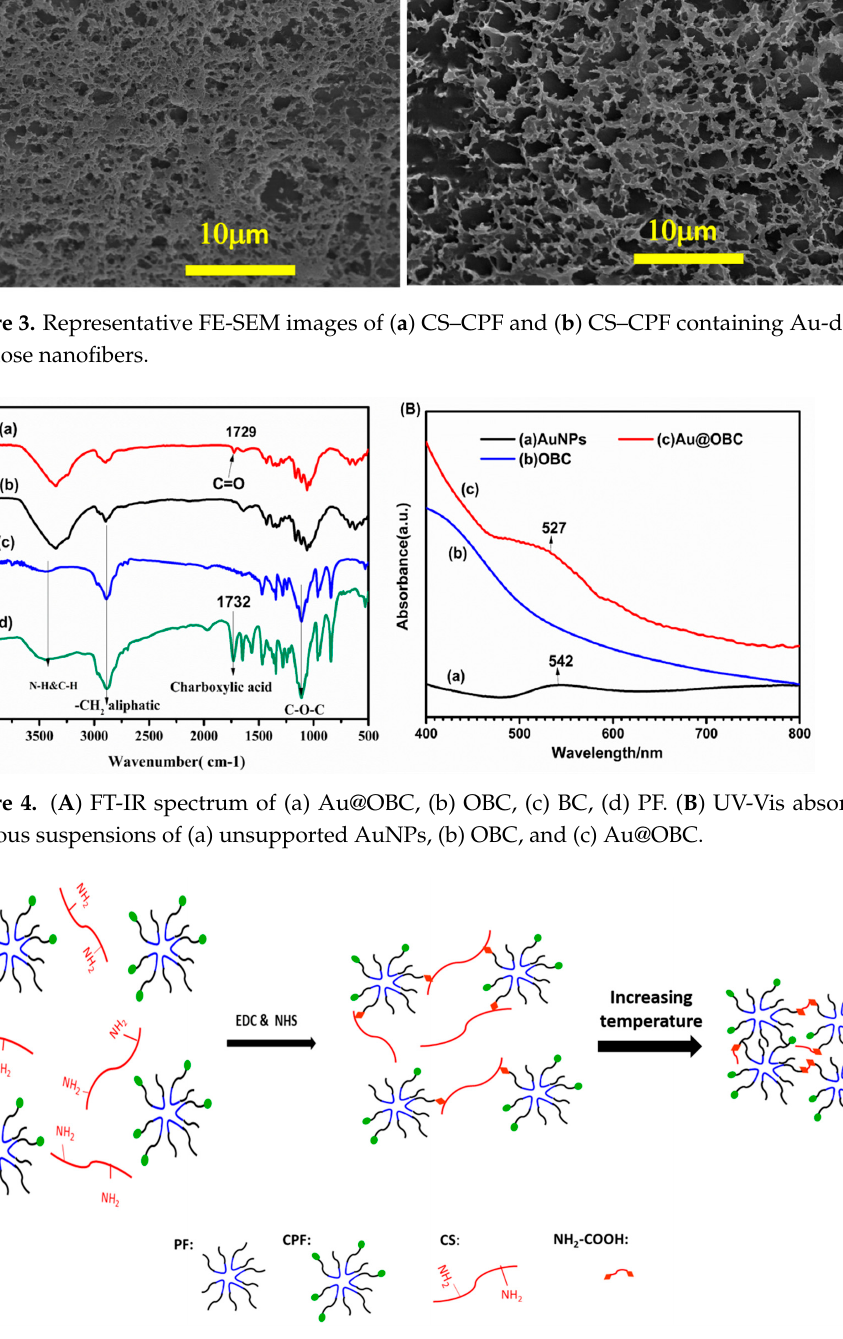
Figure 3. Representative FE-SEM images of ( a ) CS–CPF and ( b ) CS–CPF containing Au-decorated cellulose nanofibers.